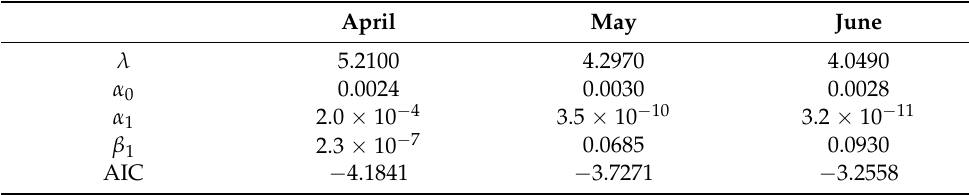
Table 2. Symmetric HN parameters.